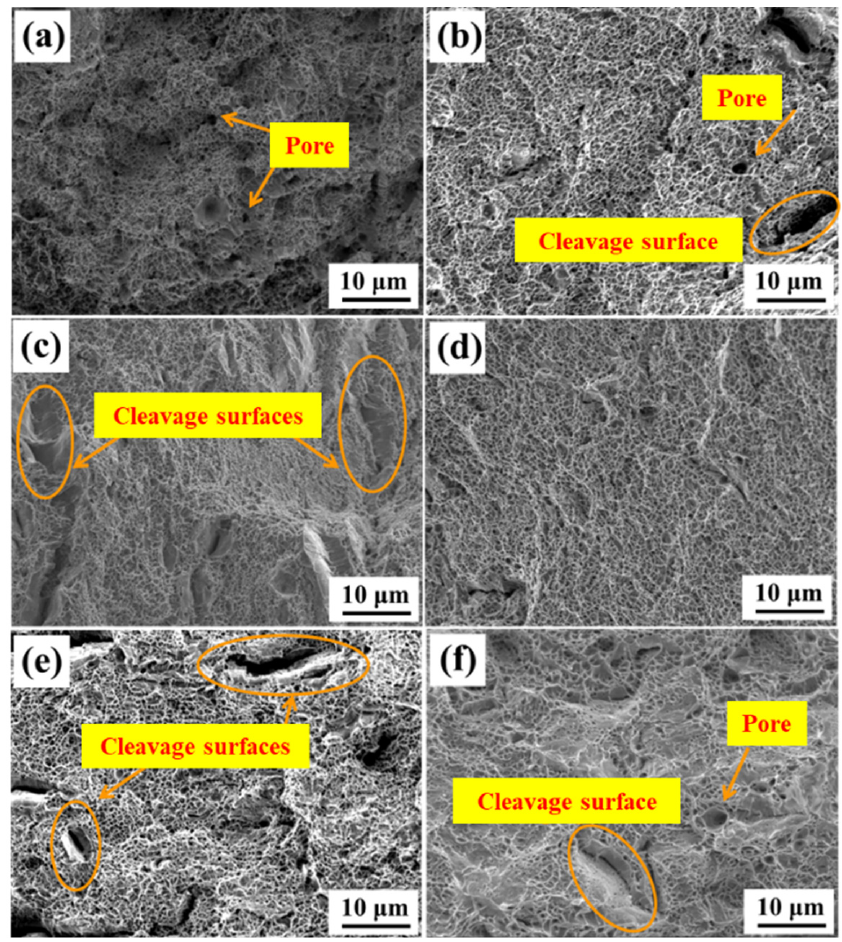
Figure 9. SEM images of the morphology of the tensile fracture of 17-4PH high-strength steel formed by SLM. ( a ) SLM-formed sample; ( b ) sample heat-treated in solution at 940 °C; ( c ) sample heat-treated in solution at 990 °C; ( d ) sample heat-treated in solution at 1040 °C; ( e ) sample heat-treated in solution at 1090 °C; ( f ) sample heat-treated in solution at 1140 °C.